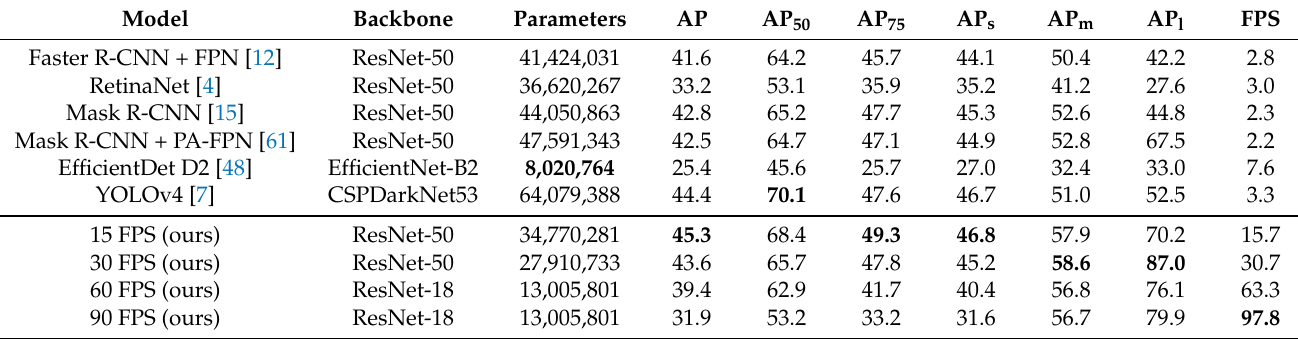
Table 1. Comparison of our proposed object detector to different state-of-the-art detectors. Even though the compared detectors are close in terms of accuracy, our detectors have a significantly higher frame rate. The increased accuracy compared to the baseline RetinaNet are due to the multiple improvements mentioned in Section 3.2. The main reasons for the increased performance of the 15 FPS model are the application of TensorRT and half-precision floating-point. The faster models benefit from carefully scaling the backbone, the head and the